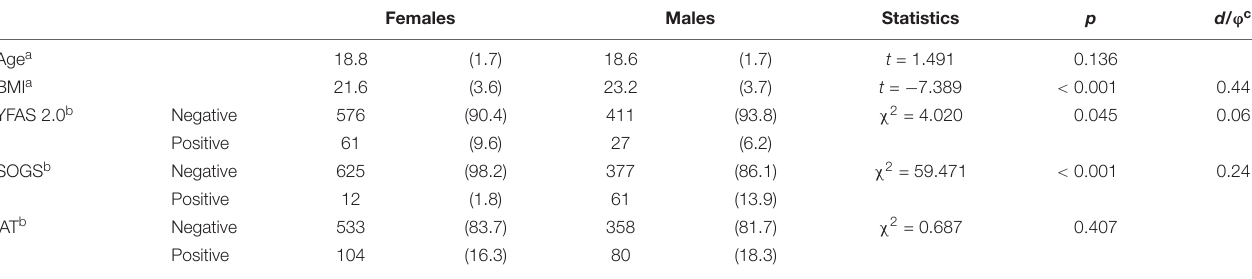
TABLE 1 | Sample demographics and distribution of behavioral addictions.